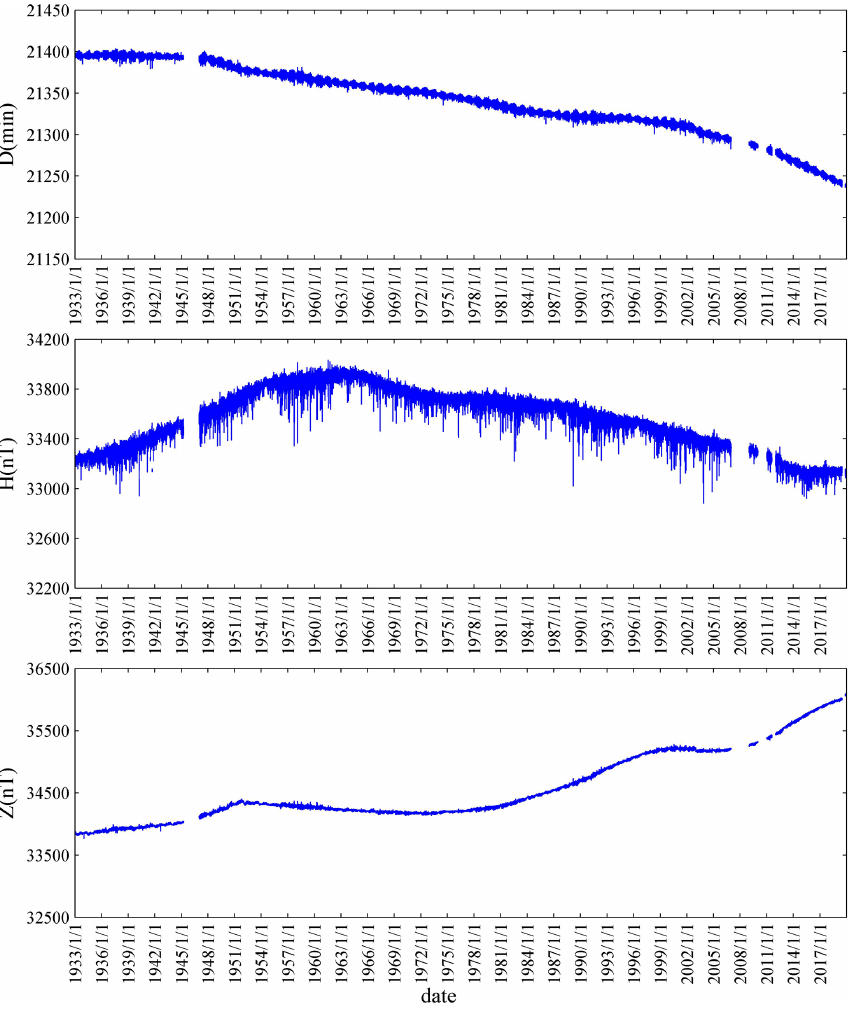
Figure 5. The AHMV plots of D , H , and Z components for all time from 1933 to 2019.